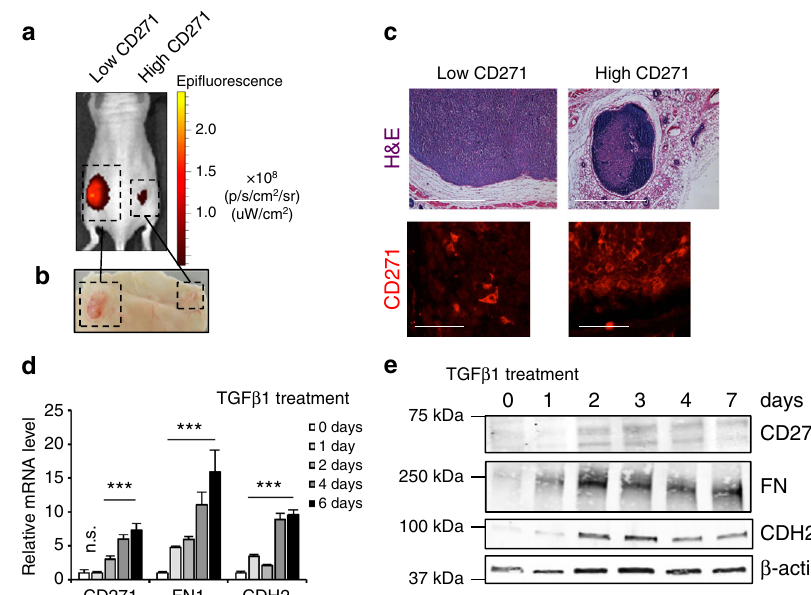
Fig. 2 Endogenous levels of CD271 in fl uence tumor growth. a , b Melanoma cell lines with different levels of CD271 (CD271 low = M010817; CD271 high = M050829 were stably transduced with lentiviral backbones expressing infrared fl uorescent protein (iRFP) and injected in to Nude mice. The growth of the xenografts was assessed by IVIS a and macroscopically after euthanasia b . c H&E staining and CD271 immuno fl uorescence of tumors formed from low and high CD271-expressing melanoma cells. Scale bars upper panel 2 mm, scale bars lower panel 50 µ m. d , e qRT-PCR and western blot of the CD271 low melanoma cell line (M010817) treated with TGF β 1 ligand (5 ng/ml) at different time points. (FN: Fibronectin; CDH2: N-cadherin; β -act.: beta actin). N = 3, P values CD271 > 0.05 and ≤ 0.001, P value FN ≤ 0.001, P value N-cadh. ≤ 0.001. Error bars indicate